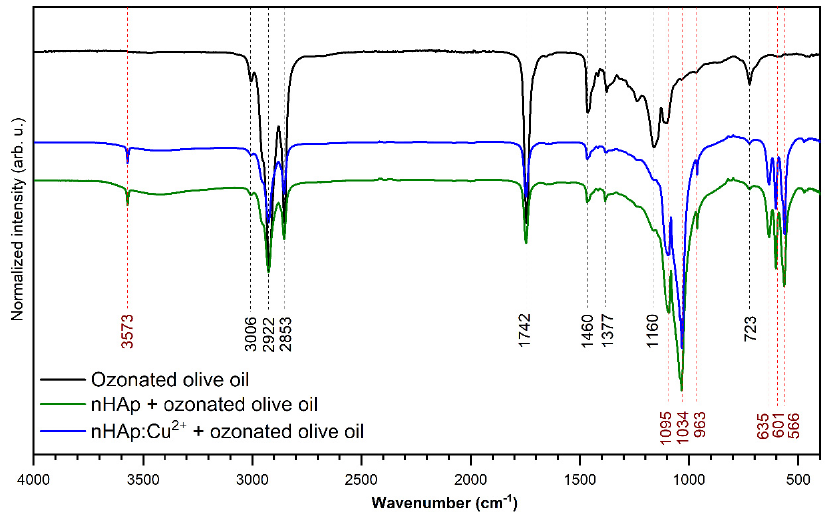
Figure 3. FT-IR spectra of ozonated olive oil as well as nHAp and nHAp doped with 1 mol% Cu 2 + and loaded with ozonated olive oil.